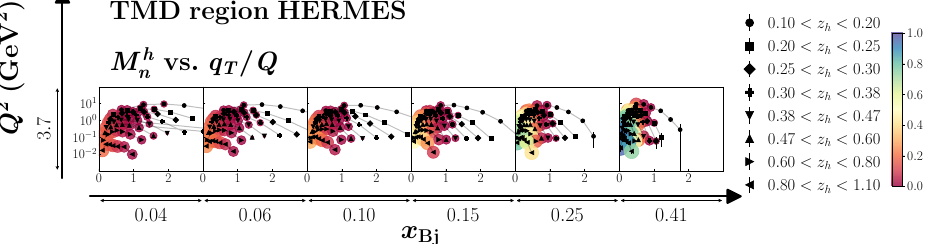
[46] (black points) as a function of P hT n bins with the top h . h